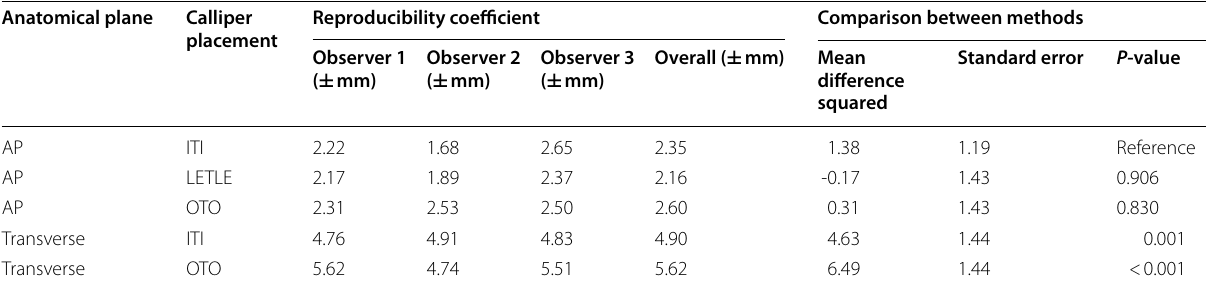
Table 2 Intra-observer reproducibility coefficients